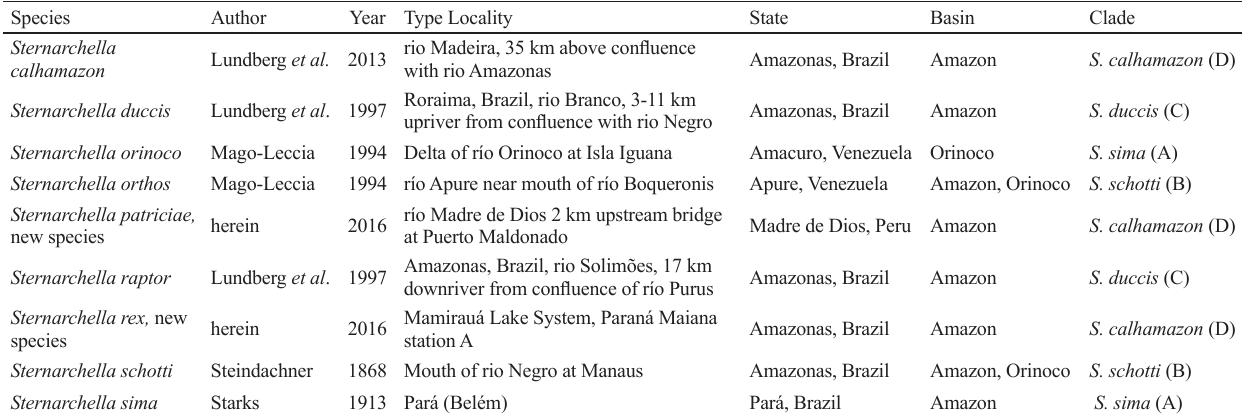
Tab. 1. Summary of taxonomic data on valid species of Sternarchella